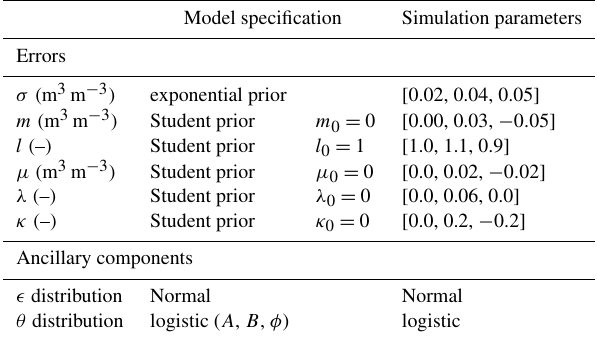
Table 1. The default model specification used in both the simulation study and the SMAP case study, and the baseline configuration for the simulation runs. The bias terms for the reference product y 0 were assumed